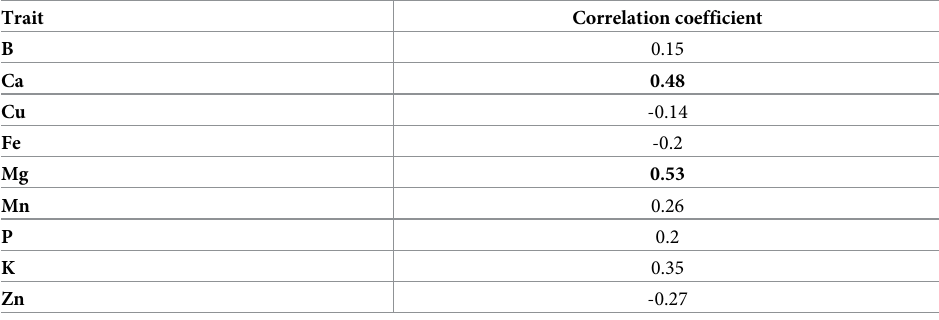
Table 4. ICP-MS and ICP-OES correlation coefficients with p < 0.05